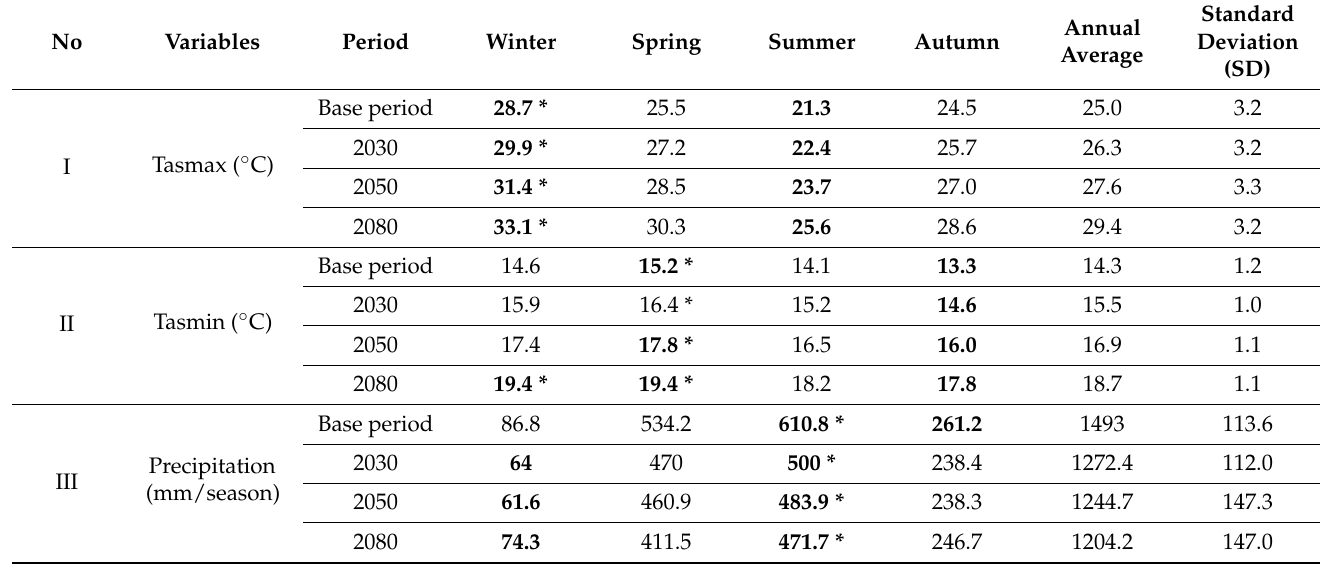
Table 4. Computed seasonal multi-model results of the areal average of maximum, minimum temperature ( ◦ C), and precipitation (mm) in the future time periods, comparing to the historical base period (1971–2005), near-term 2030s (2021–2040), mid-term 2050s (2041–2070), and long-term 2080s (2071–2100) data under the RCP8.5 scenario over the urban centers of southwest Ethiopia. Values in bold only indicate the smallest, and bold with * indicate the largest value within the time period. Please note that the average temperature ≥ 30 ◦ C range implies the occurrence of seasonal extreme temperature events across time